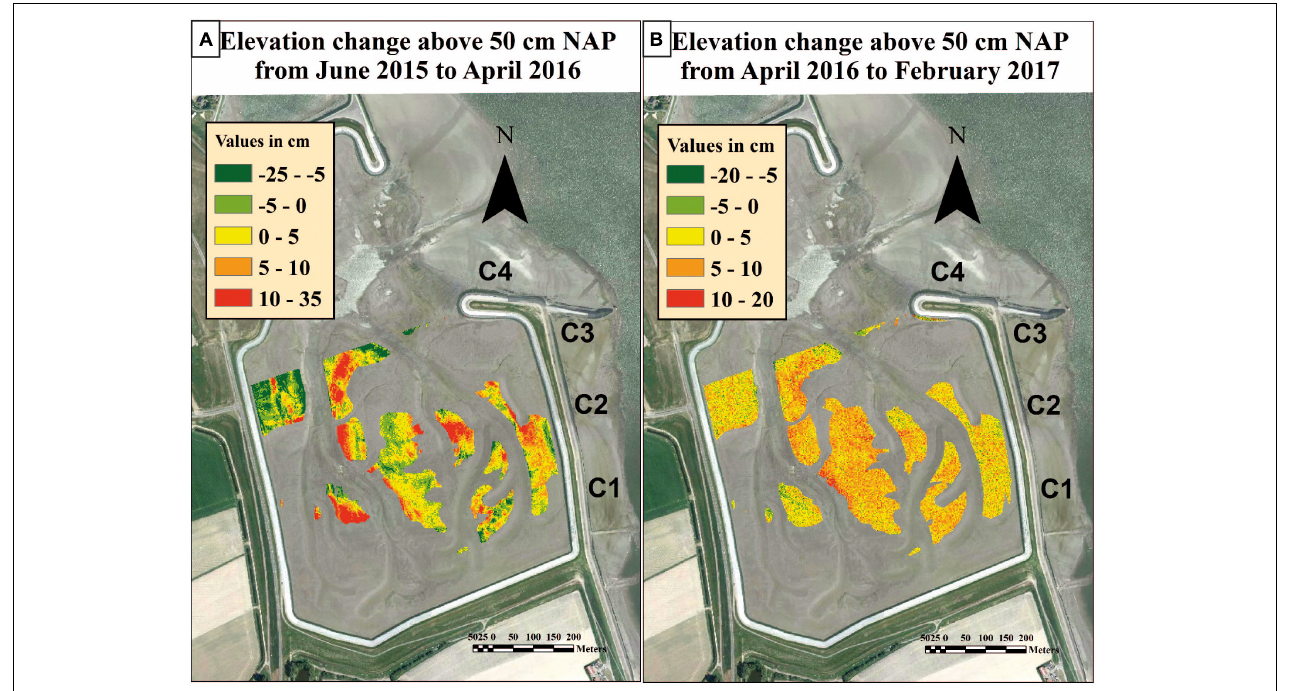
FIGURE 11 | On the left (A) elevation changes from June 2015 to April 2016 and on the right (B) from April 2016 to February 2017.